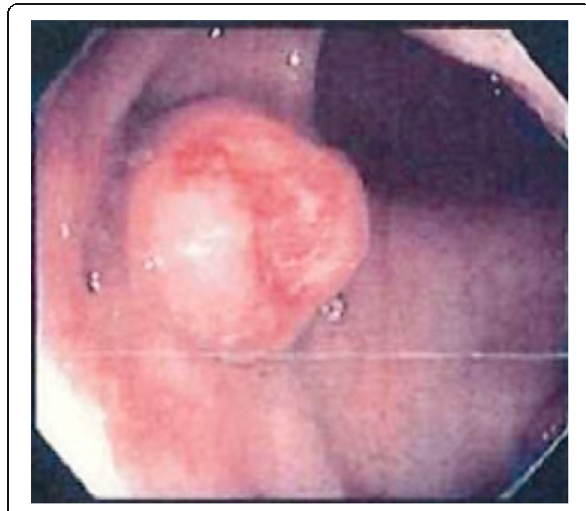
Fig. 1 Endoscopy image of the primary tumor in case 1. Submucosal tumor with ulcer in the